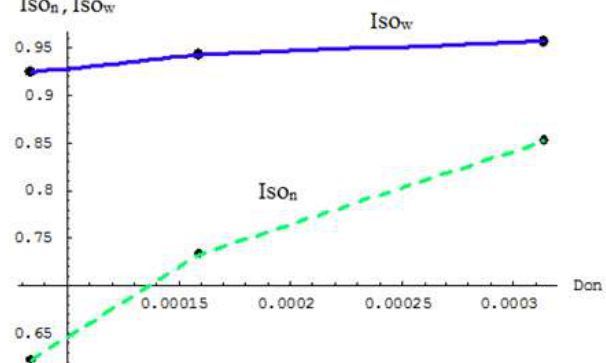
Figure 5. Dependence on the initial concentration of the electron donor of the polydispersity coeffi- cient K wn of polypropylene chains synthesized at the residence time in the reactor τ = 60 min.